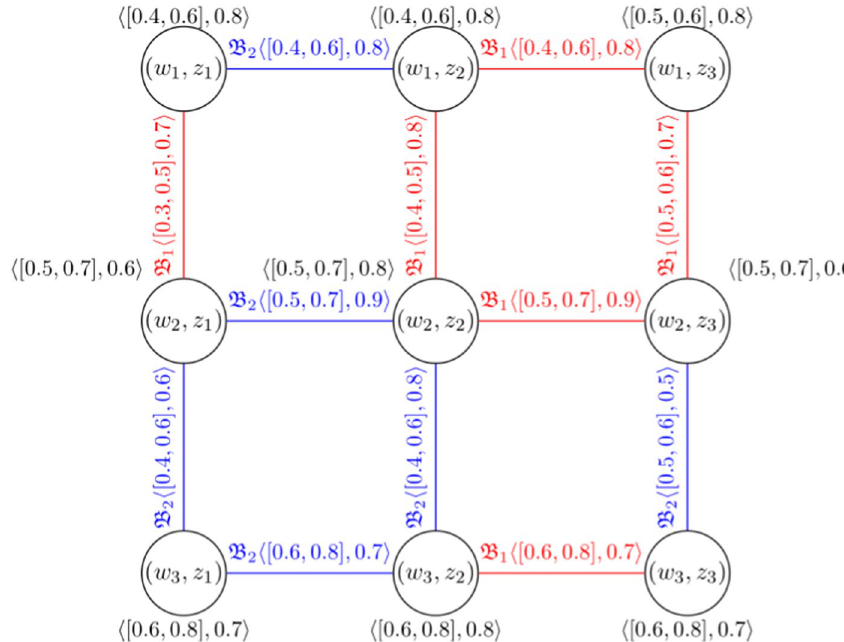
Fig. 3 Maximal product of two CFGSs G and G 𝔊 = ( 𝔄 , 𝔅